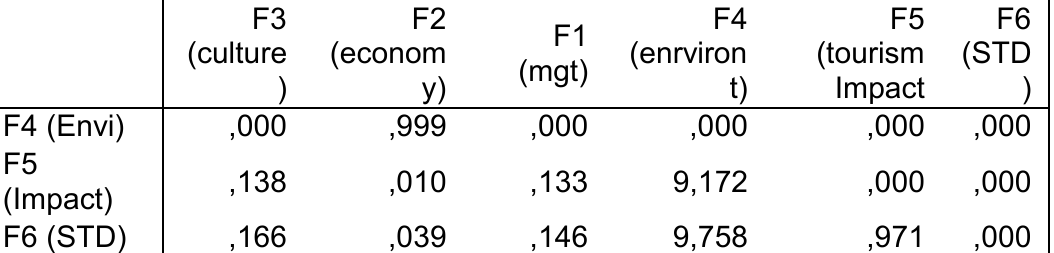
Table 5. Standardized Total Effects